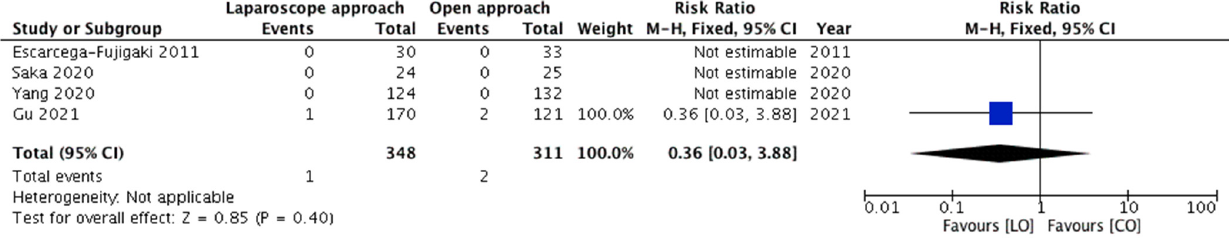
Figure 7. Forest plot comparison between the two treatment groups in regard to the occurrence of testicular atrophy after excluding the children with peeping testes.